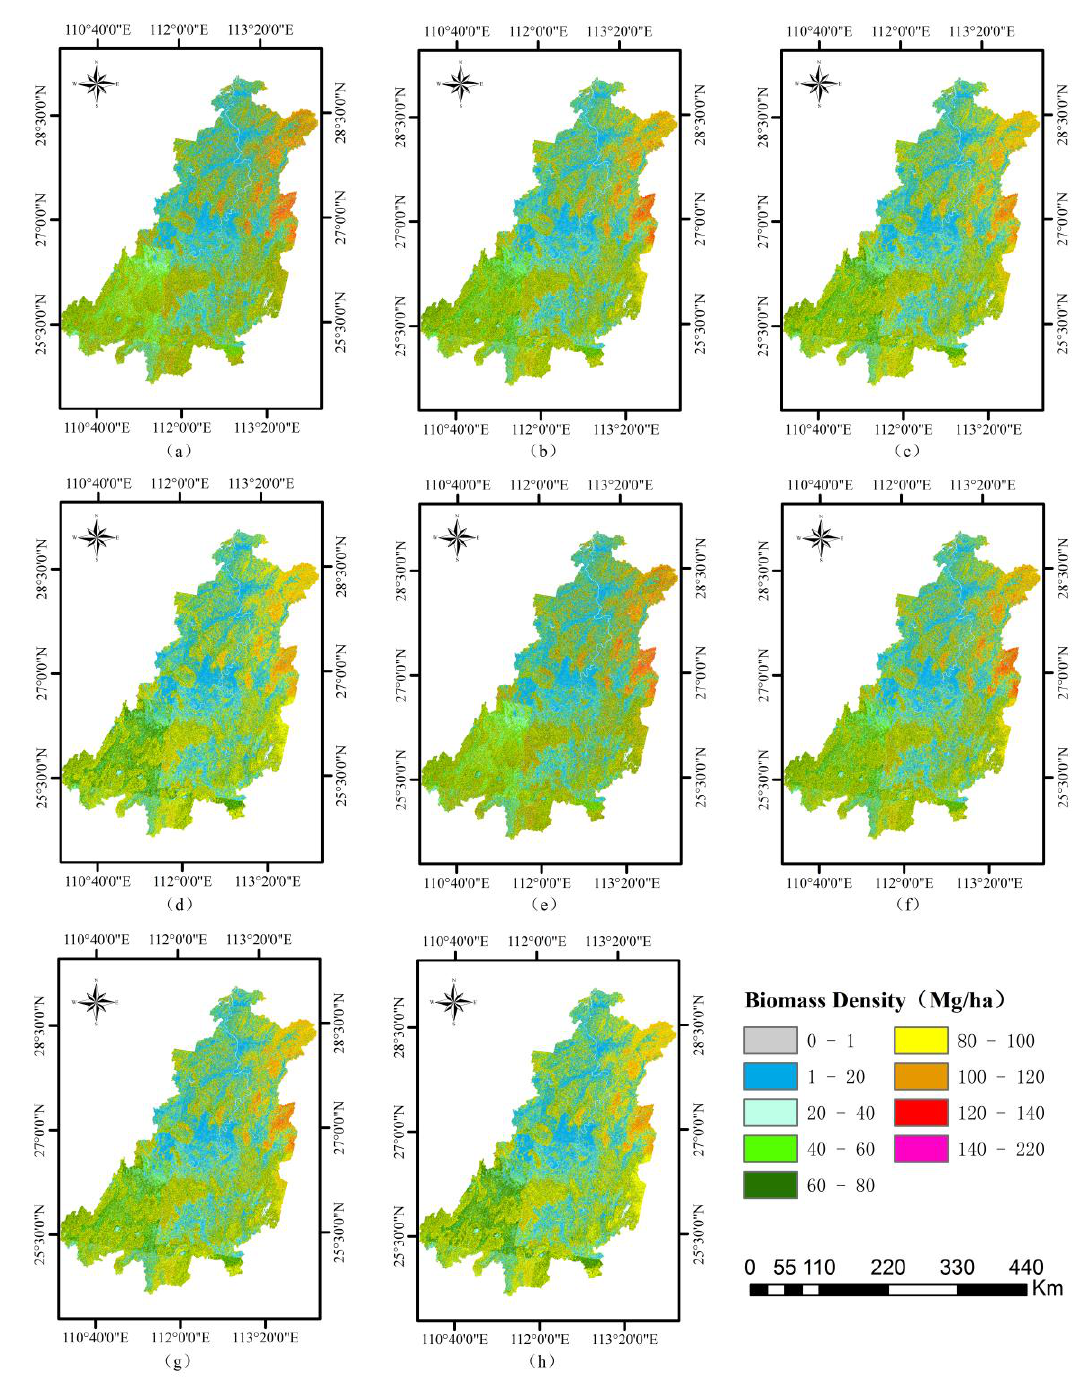
Figure A3. Spatial distributions, that is, maps of above-ground biomass density (AGB) predictions for the basin by using general k nearest neighbors (g-kNN) algorithm with numbers of nearest neighbors: ( a ) k = 3; ( b ) k = 5; ( c ) k = 7; and ( d ) k = 10; and spectral variable-AGB correlation-weighted kNN (CW-kNN) algorithm with numbers of nearest neighbors: ( e ) k = 3; ( f ) k = 5; ( g ) k = 7; and ( h ) k =